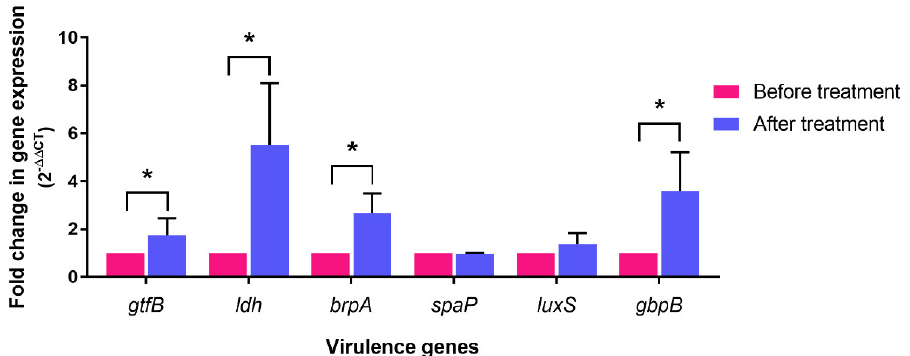
Figure 4. Fold change in gtfB , ldh , brpA , spaP , luxS , and gbpB gene expression in dental biofilm after orthodontic treatment ( n = 24). Bars represent the mean ± SEM of gene expression level relative to that of the expression level before treatment. Asterisks indicate Differentially Expressed Genes (DEGs), which were defined as at least a 1.5-fold increase.